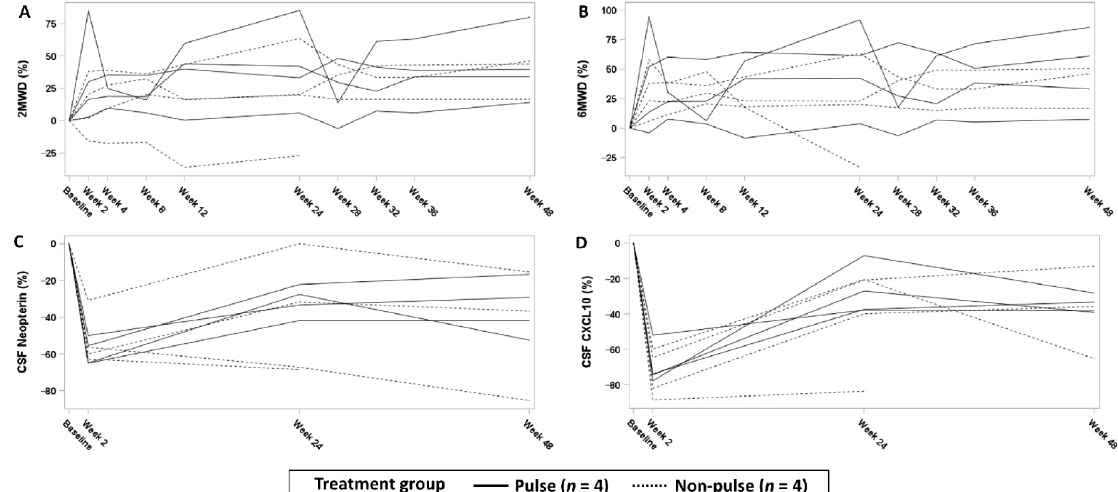
Figure 3. Changes in motor function and CSF marker concentrations from baseline in rapid progres-